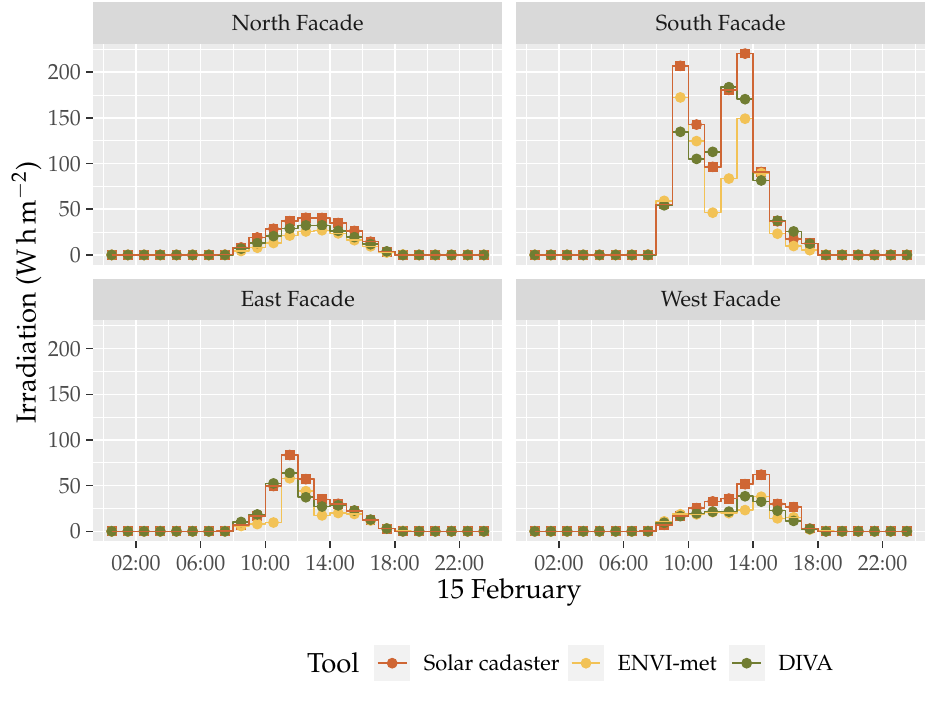
Figure 13. Spatial average irradiance received on the facades in the heterogeneous district in